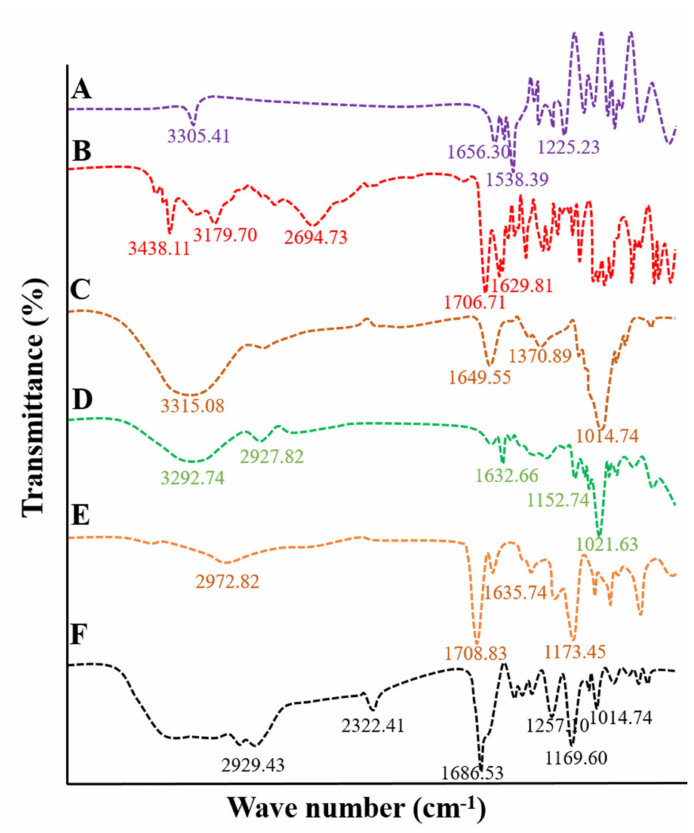
Figure 2. FTIR spectra of ( A ) MBA, ( B ) acyclovir, ( C ) tamarind gum, ( D ) β -CD, ( E ) MAA, and ( F ) formulation